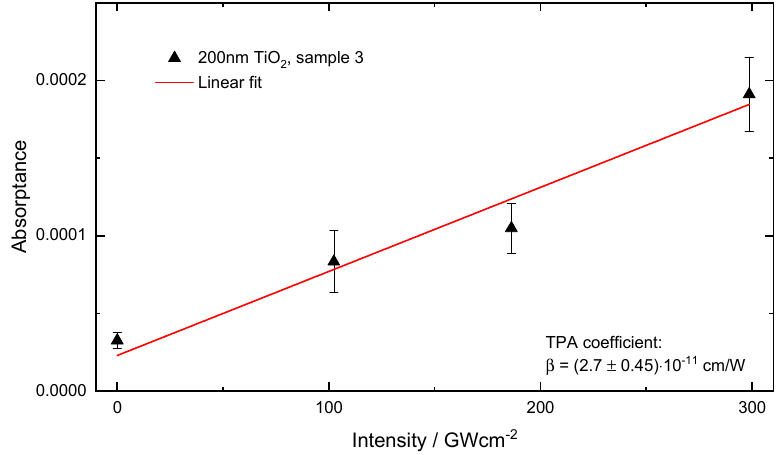
Figure 8. Absorptance versus laser intensity and the TPA coefficient for sample 3.